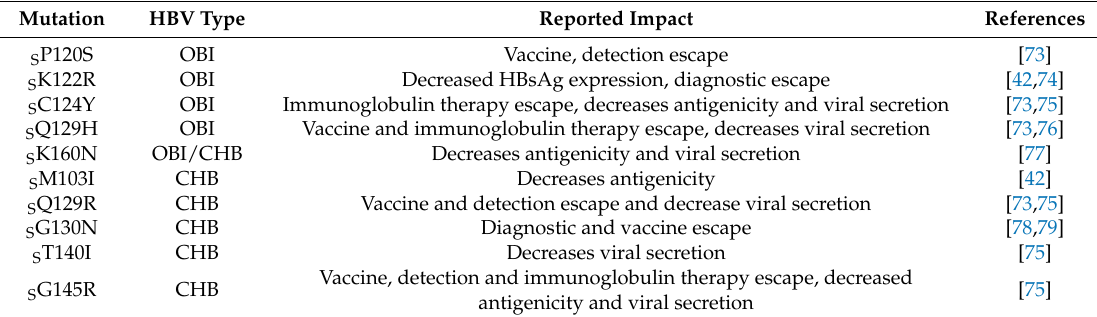
Table 3. HBV escape mutations in the S ORF of OBI versus CHB